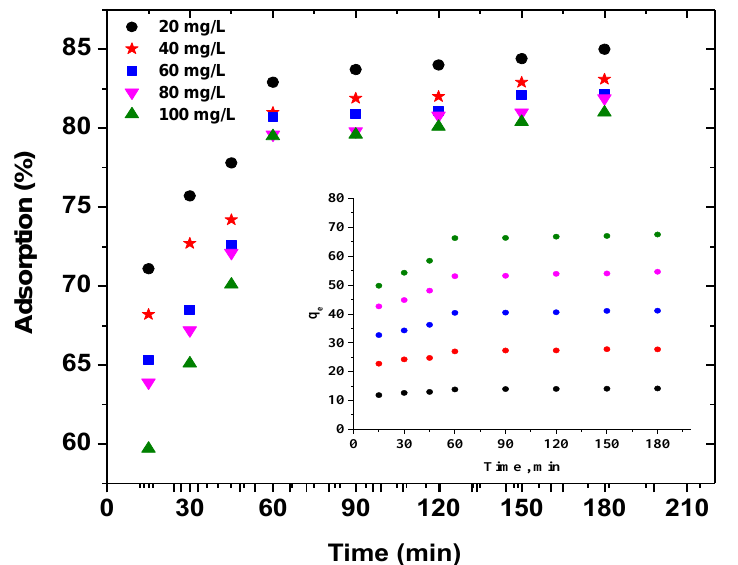
Figure 11. Effect of contact time and initial dye concentration on the adsorption of AB92 by BFO/CFO@PEG nanocomposite.